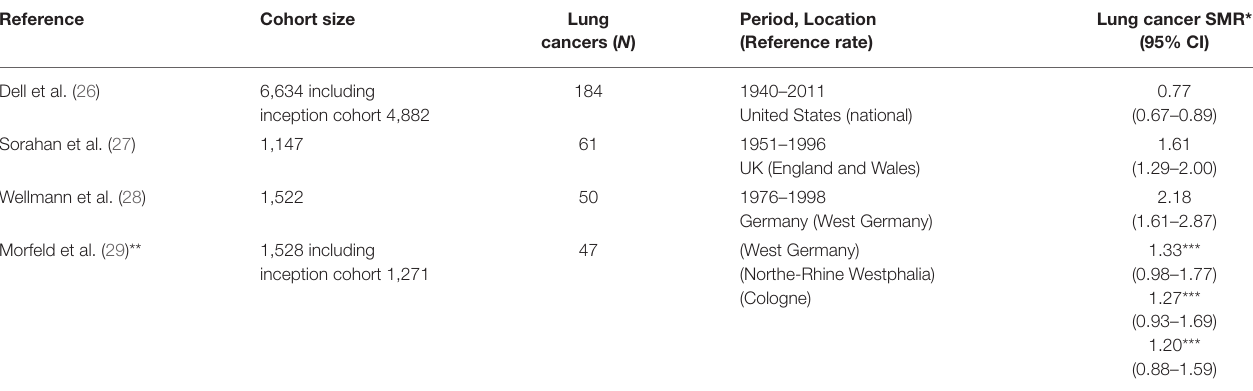
TABLE 1 | Lung cancer results from cohort studies of carbon black